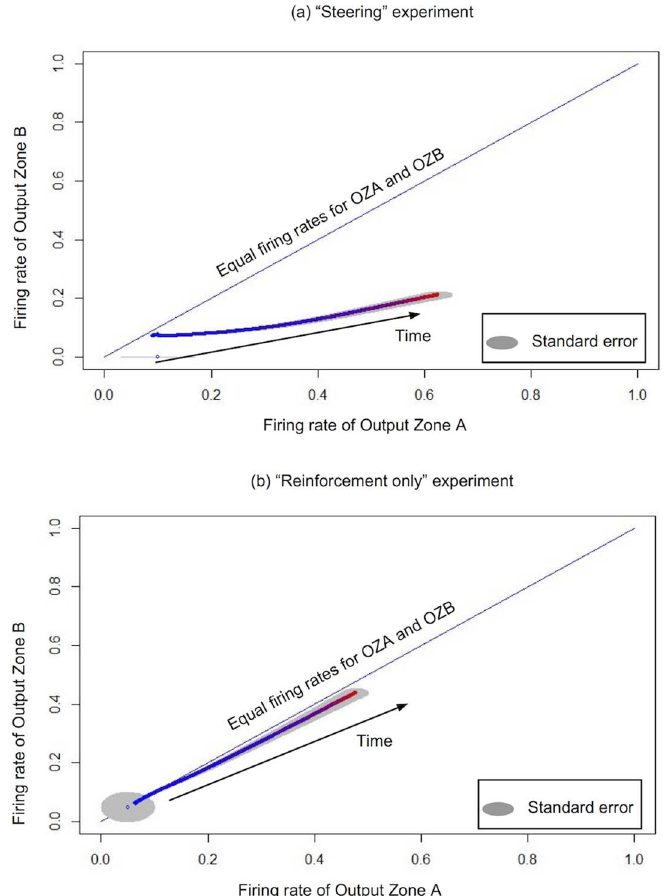
Fig 6. Trajectory of the network in the two-dimensional space of the firing rates of Output Zone A and Output Zone B. Using LSA, we can steer the network in this space; by contrast, the “reinforcement only” experiment maintainsthe network balanced relativelyto the two firing rates. (a) leads to the low external stimulationregionbut (b) does not. Statistical results for N = 20